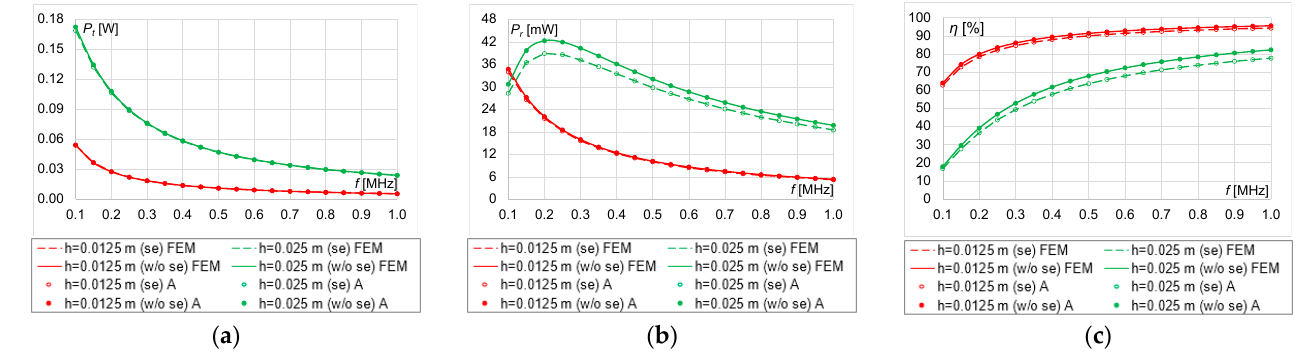
Figure 13. Results for n = 60 for the cases with and without skin effect: ( a ) P t , ( b ) P r , ( c ) η .